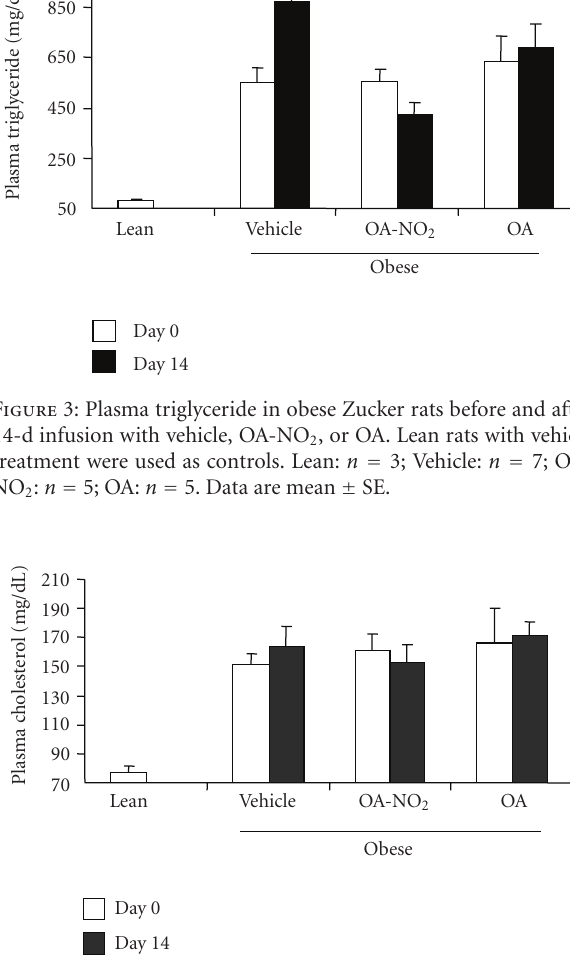
Figure 4: Plasma cholesterol in obese Zucker rats before and after 14-d infusion with vehicle, OA-NO 2 , or OA. Lean rats with vehicle treatment were used as controls. Lean: n = 3; Vehicle: n = 7; OA- NO 2 : n = 5; OA: n = 5. Data are mean ±